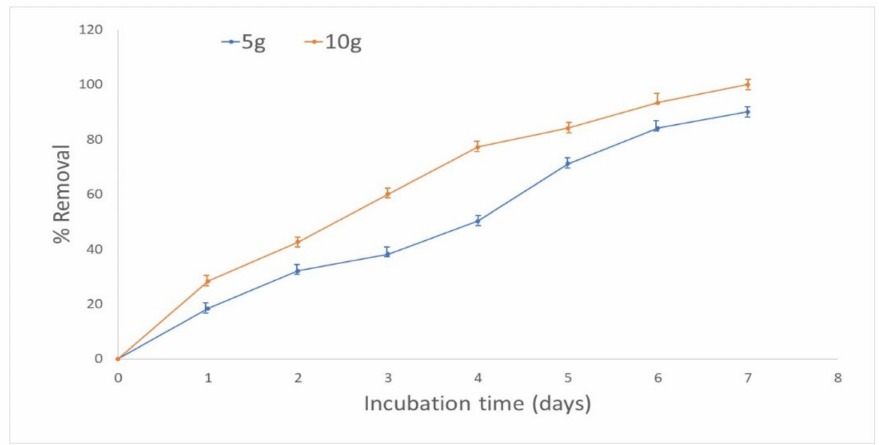
Figure 6. Cobalt (II) bioremediation by E. crassipes biomass from contaminated water (100 mL) with 100 mg of cobalt (II)/L. pH 5.0 (adjusted). 28 ◦ C. 100 rpm. 5 and 10 g of biomass.